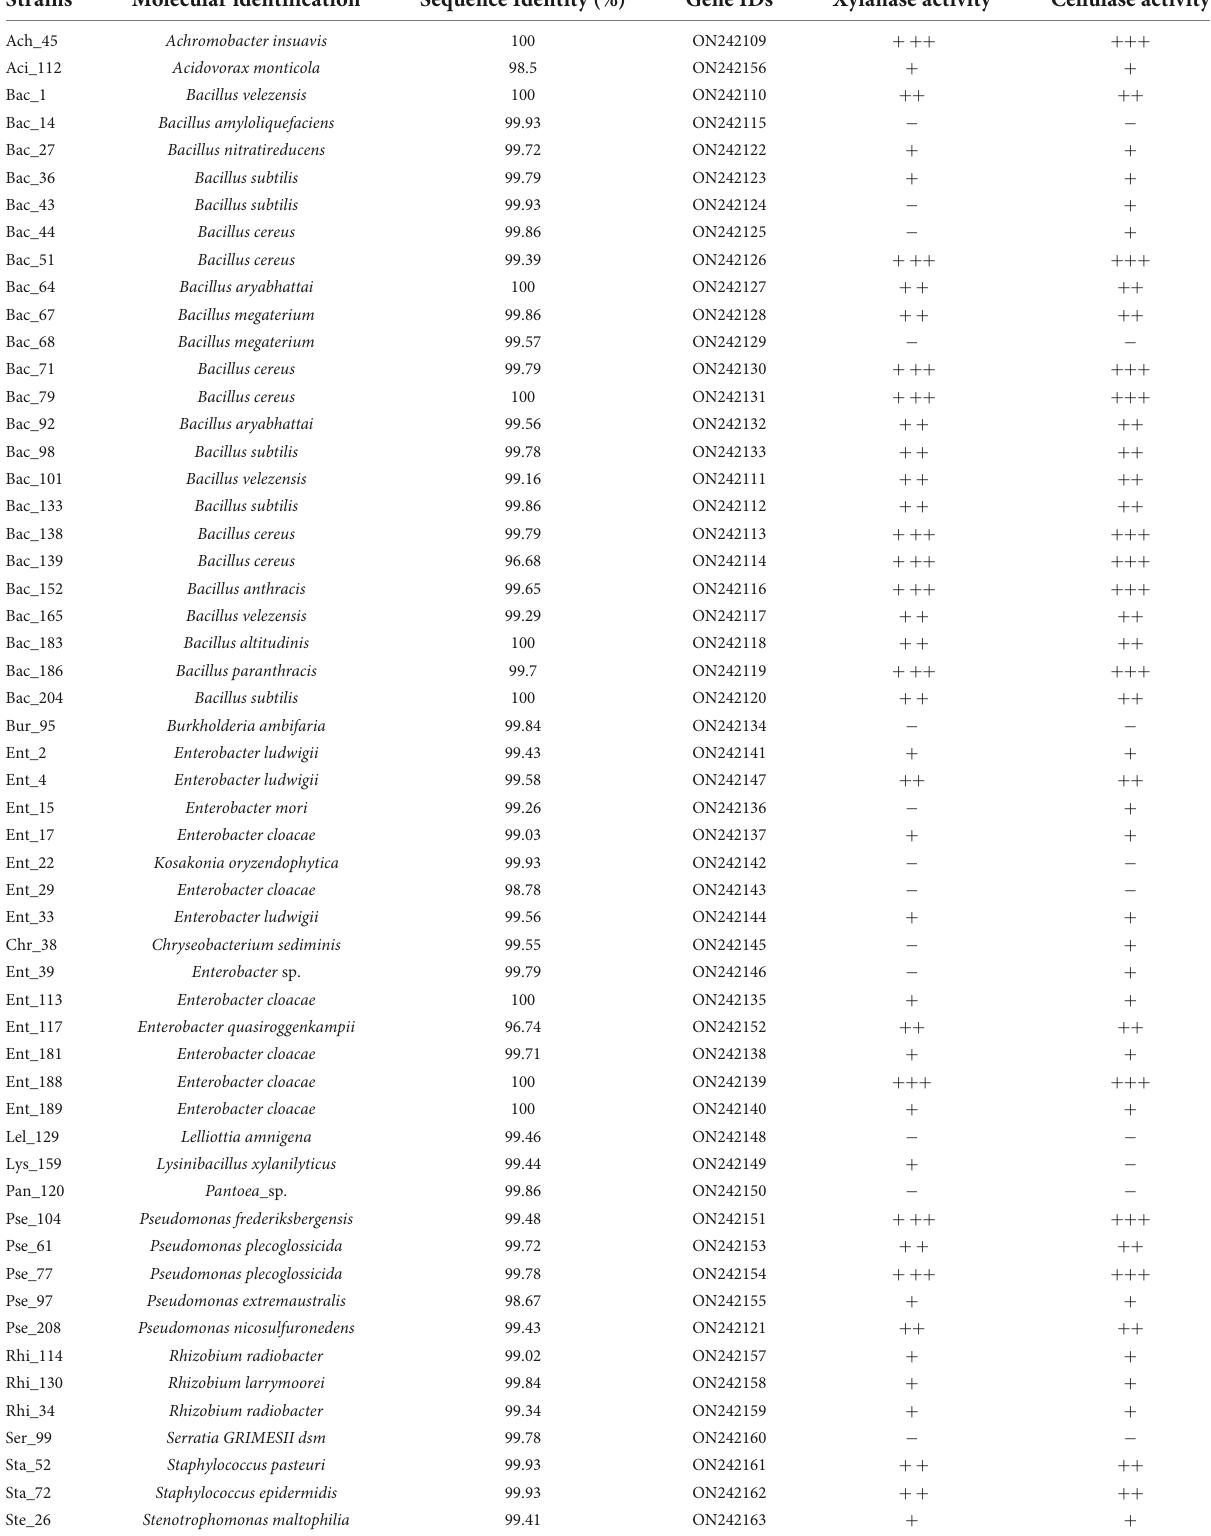
TABLE 1 Taxonomic and lignocellulose identification of 55 endophytic strains isolated from tomato root microbiota. Strains Molecular